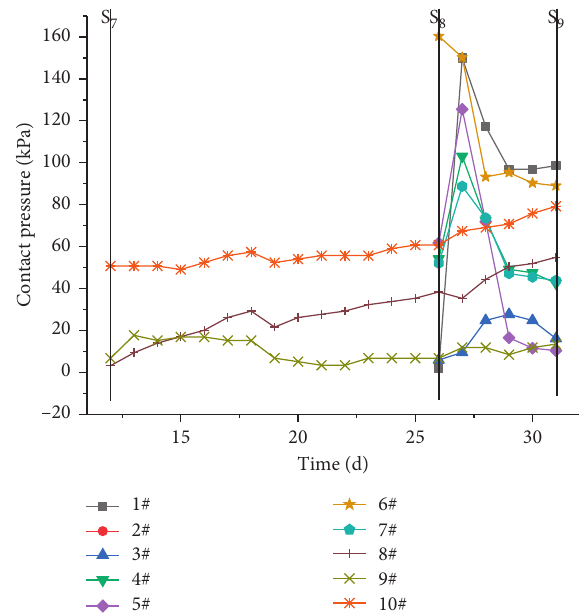
Figure 12: Change curve of DK-190+645 mileage contact pressure in early three